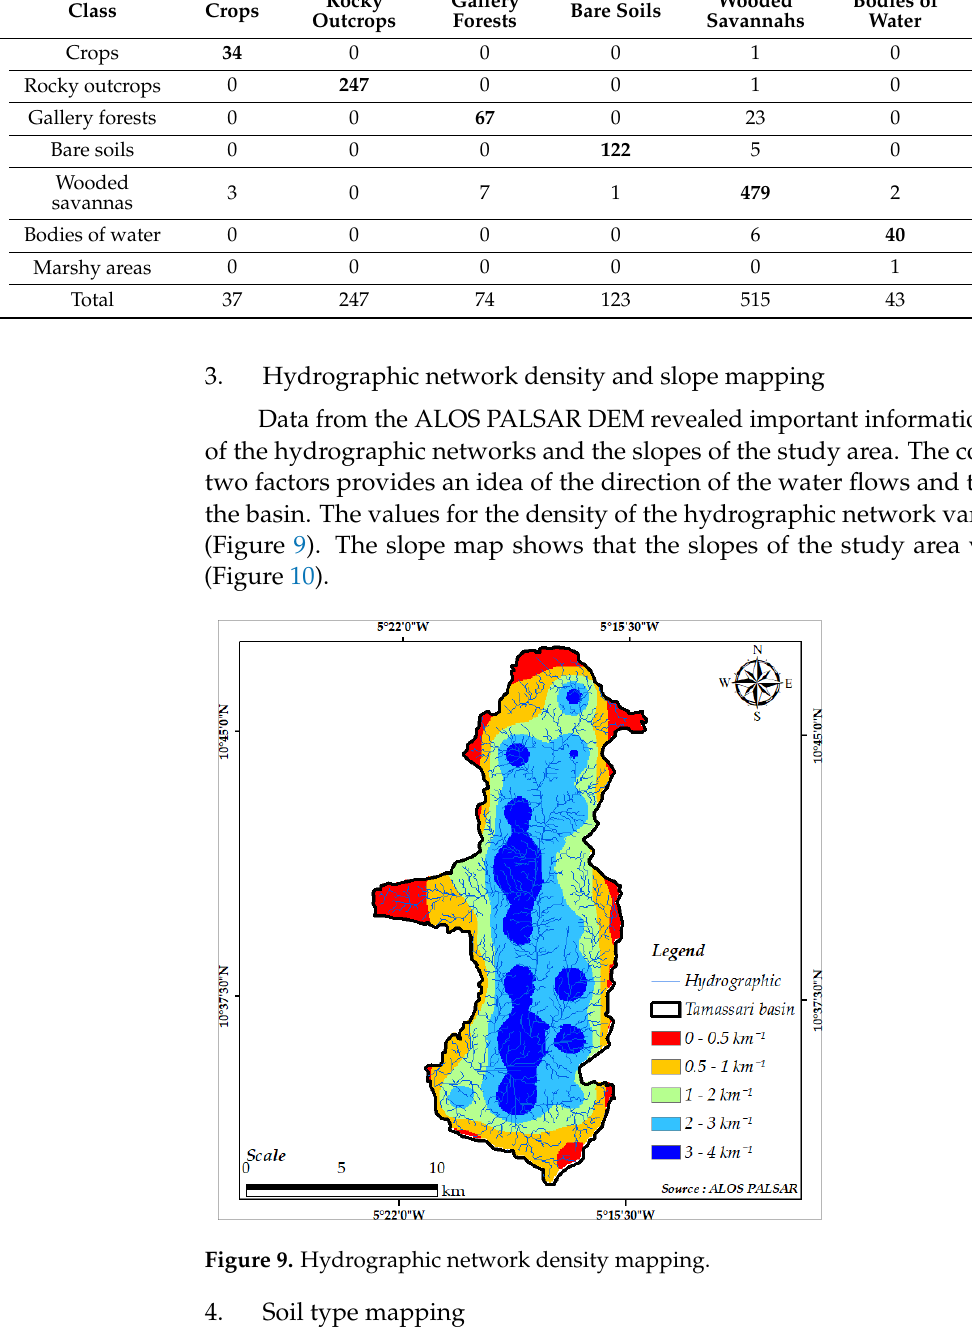
Figure 10. Slope mapping. 4.